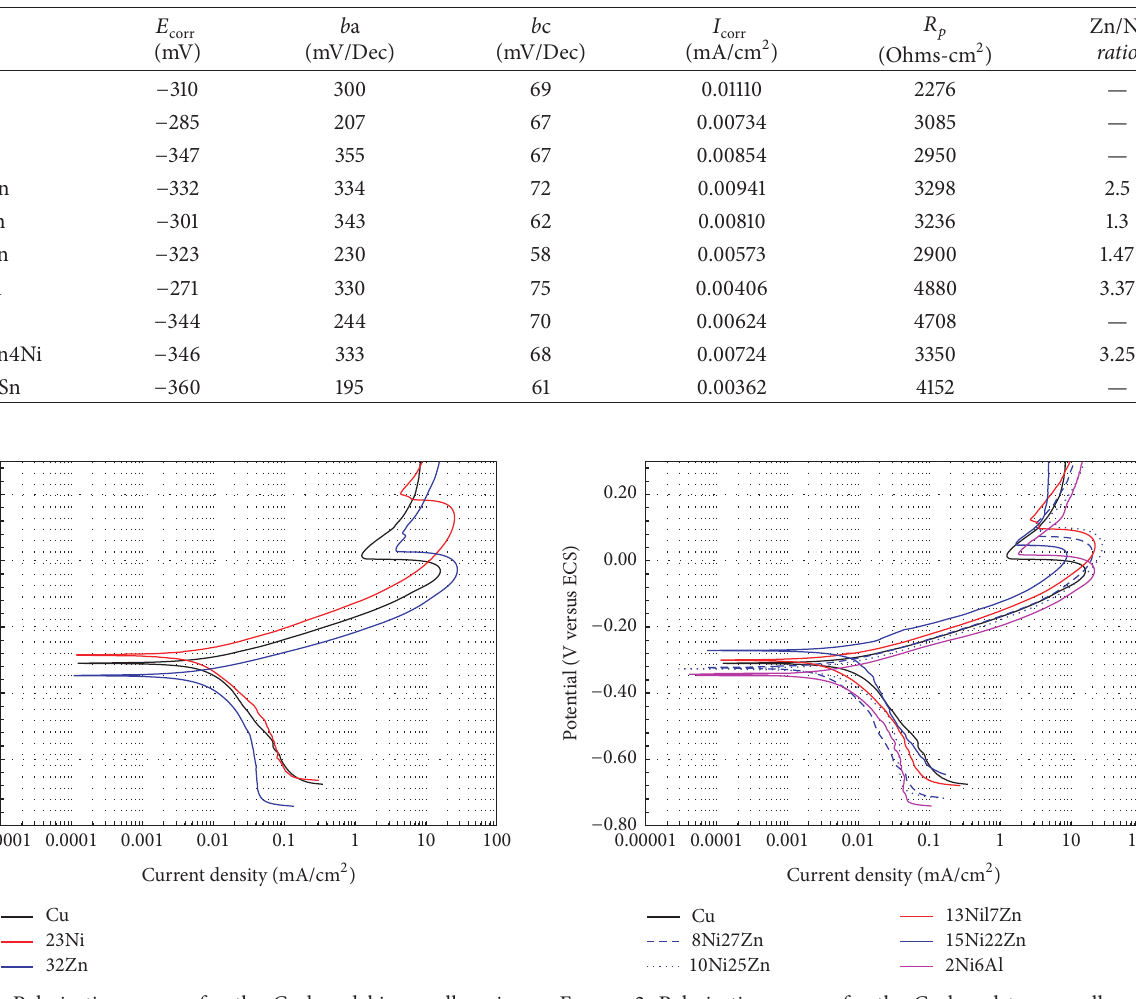
Figure 1: Polarization curves for the Cu-based binary alloys in artificial sweat at 37 ∘ C ( dE/dt = 1.0mV/s).